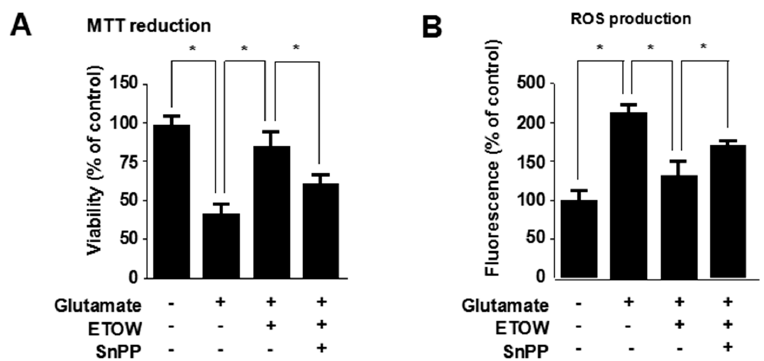
Figure 5. Effects of ETOW-induced HO-1 on glutamate-induced cytotoxicity and reactive oxygen species generation in HT22 cells. HT22 cells were pretreated with 400 µ g/mL ETOW in the presence or absence of 50 µ M SnPP and then exposed to glutamate (5 mM) for 12 h Cell viability ( A ) and ROS ( B ) production were measured by the MTT assay and DCF fluorescence measurement, respectively. Each bar represents the mean ± SD ( n = 3). * p < 0.05. The “+”and “ − ” signs indicates the presence or